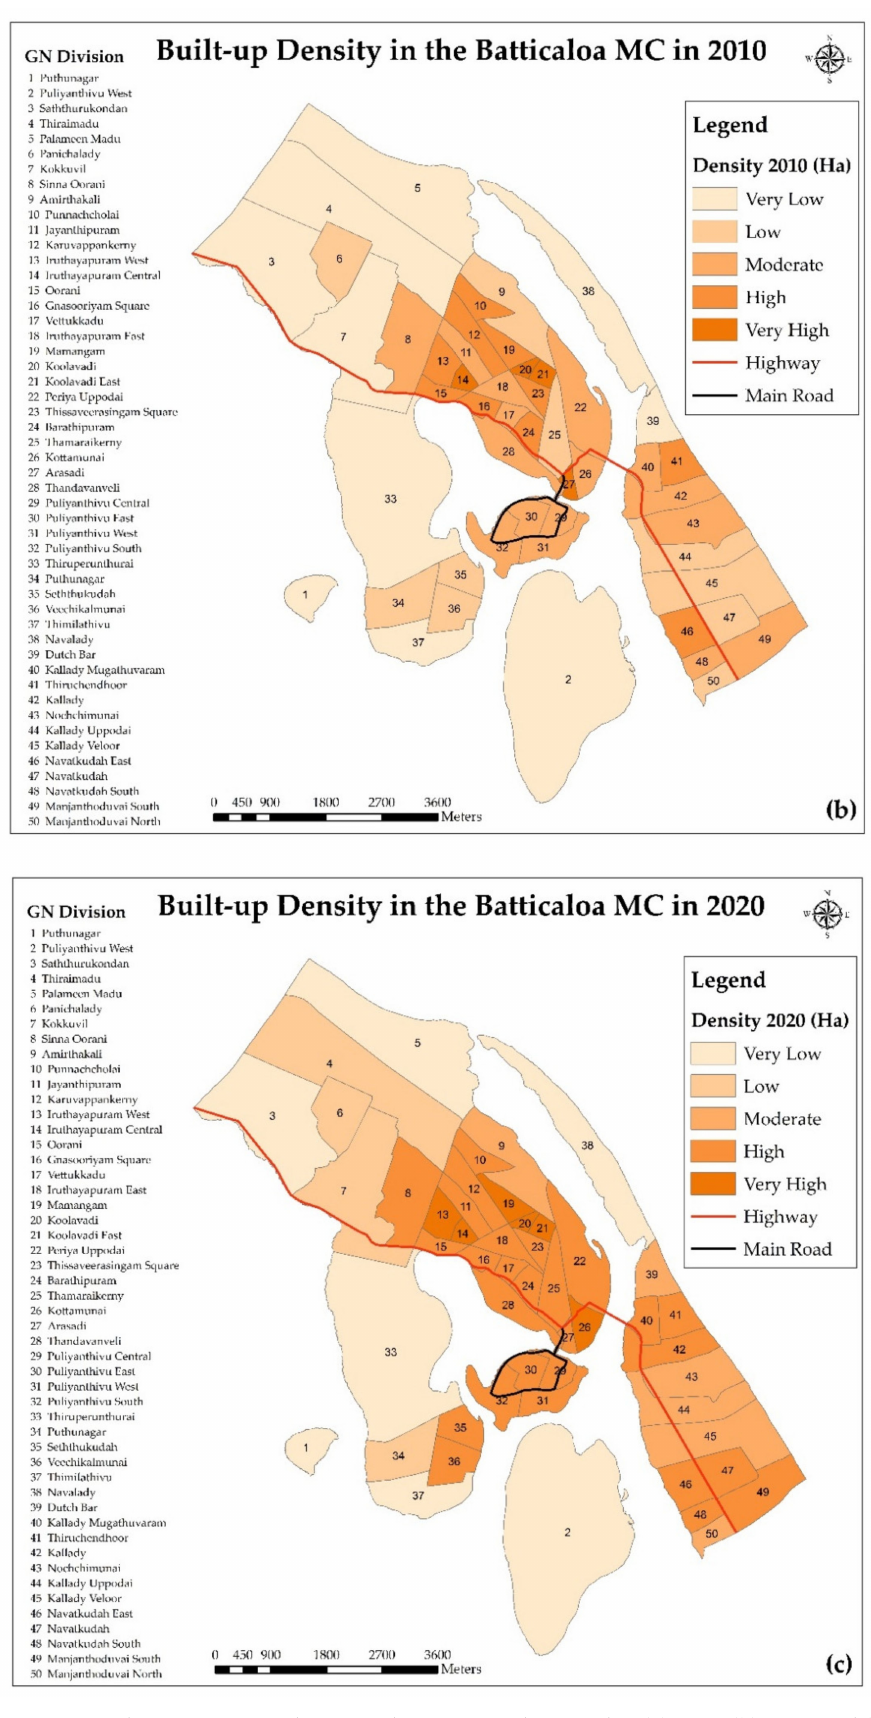
Figure 6. Built-up Density in the Batticaloa Municipal Council in ( a ) 2000, ( b ) 2010, and ( c )